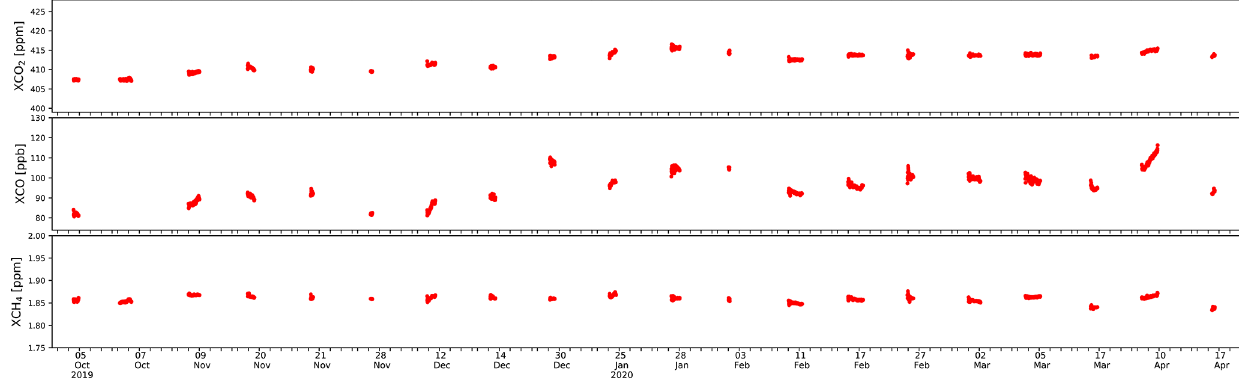
et al. (2014), Makarova et al. (2015a, b) and Timofeyev et al. (2016). A slightly higher XCH 4 is observed at the end of 2019 for all data